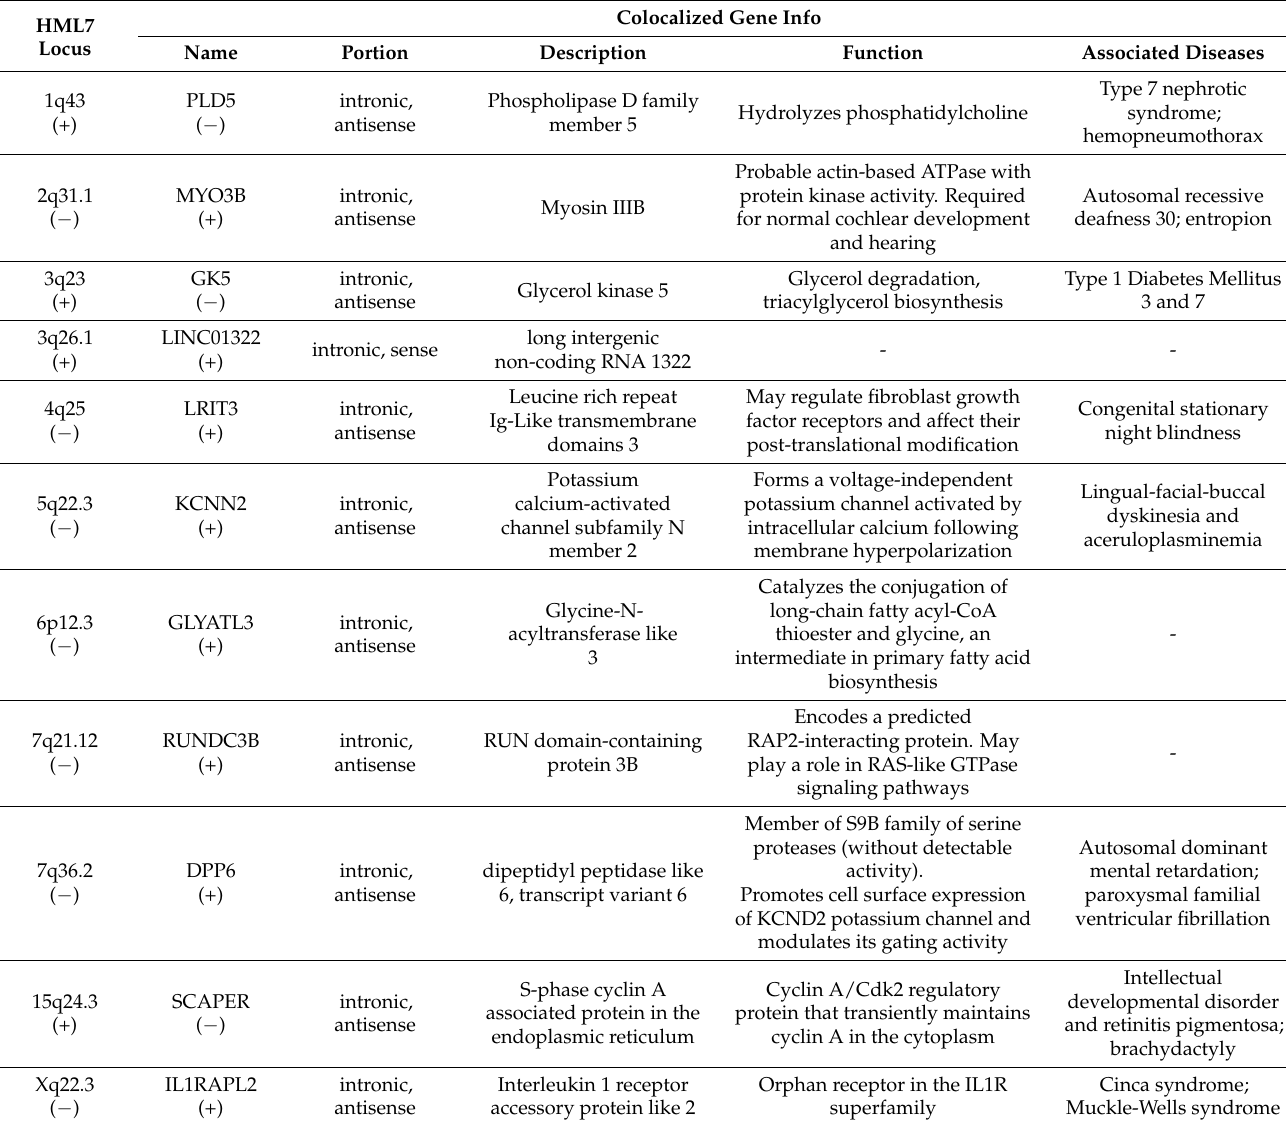
Table 2. HML7 proviral sequences colocalized with cellular